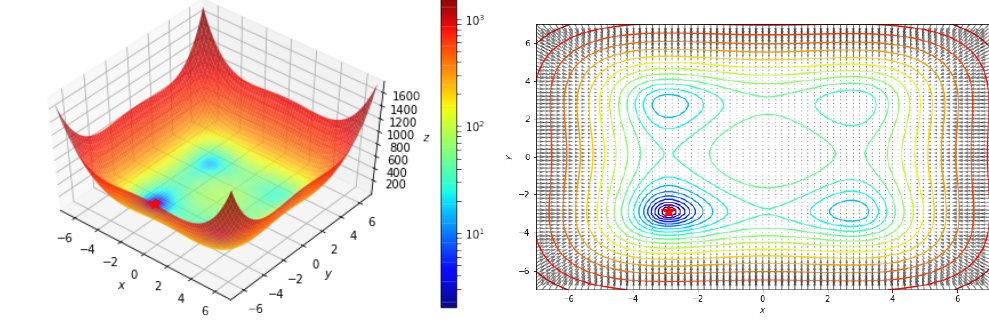
Figure 7. Styblinski–Tang Function.